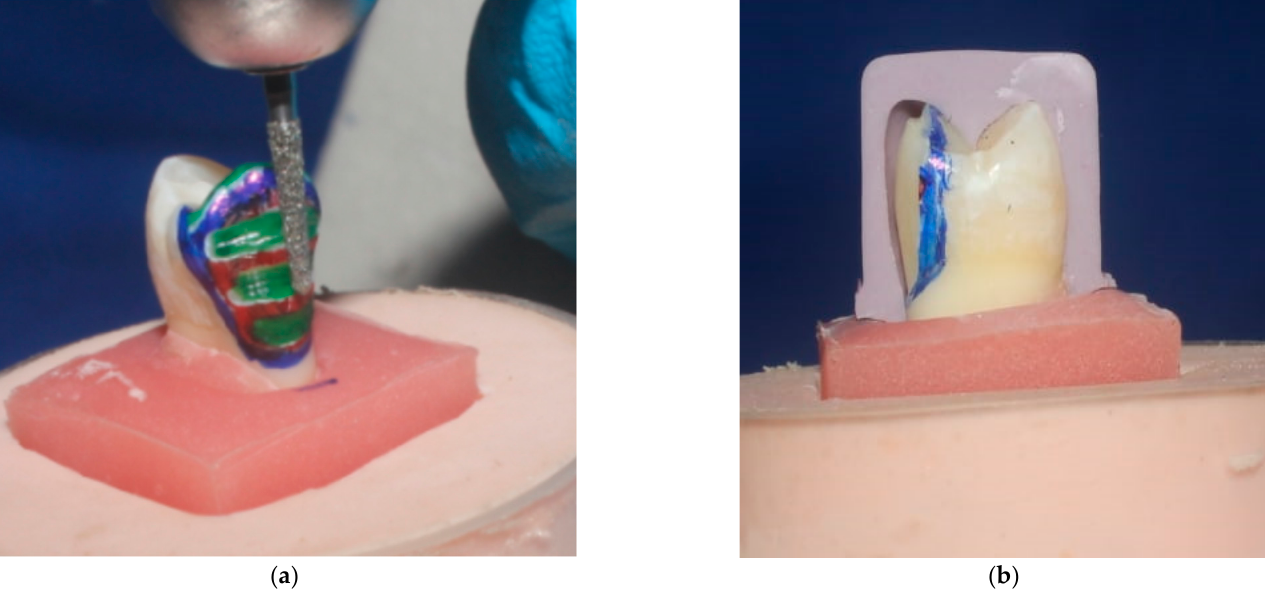
Figure 2. ( a ) Veneer preparation with tapered fissure diamond bur used for the removal of the tooth structure between the depth grooves and ( b ) Silicone index to check the preparation.